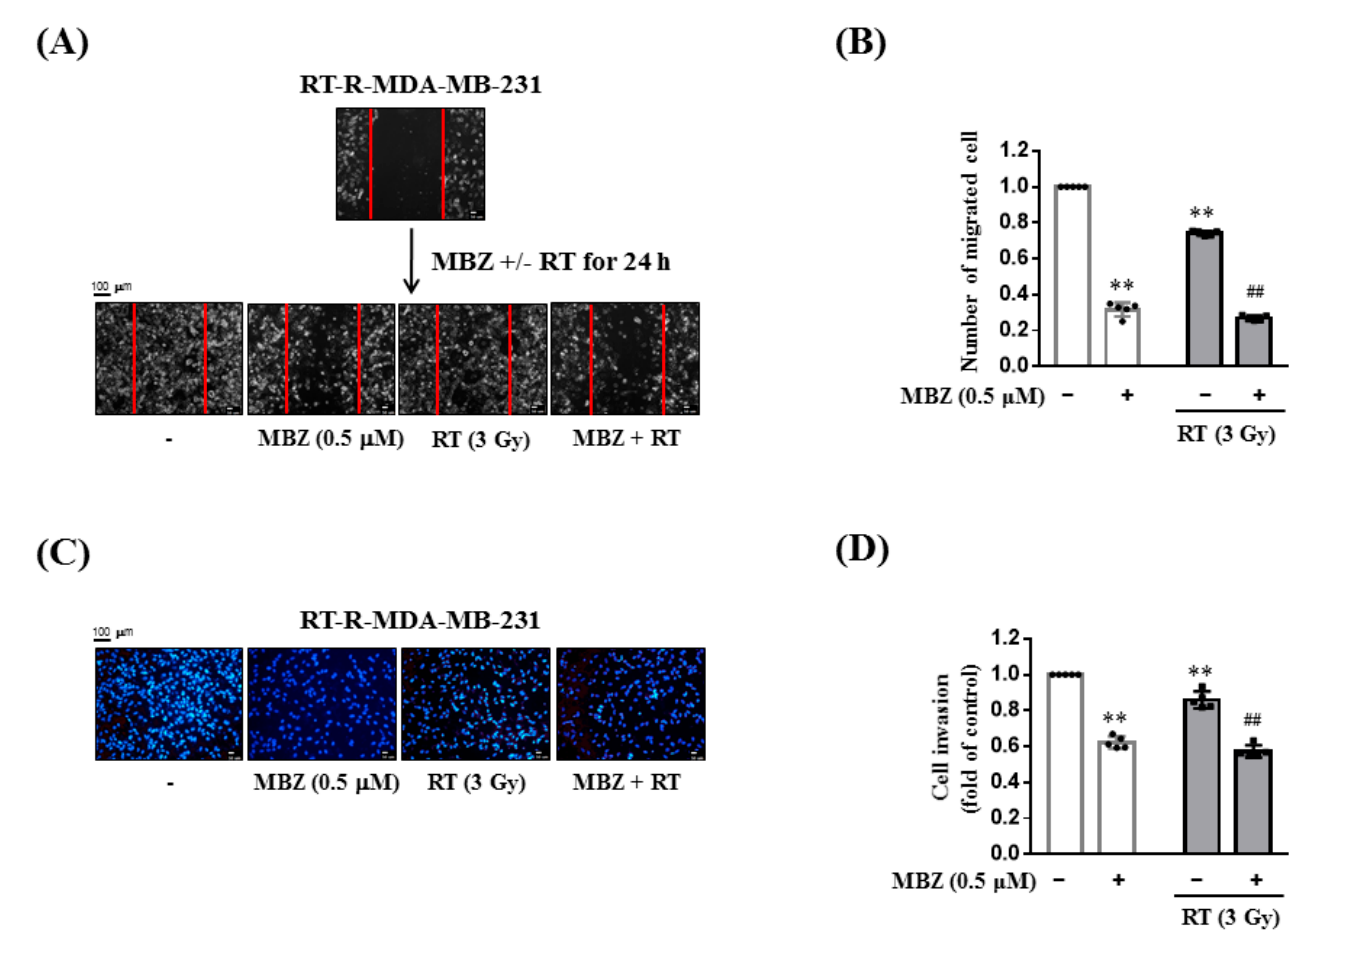
Figure 4. The combination of mebendazole (MBZ) and radiotherapy (RT) reduces scratch migration and cell invasion more effectively than RT monotherapy. ( A , B ) RT-resistant (RT-R)-MDA-MB-231 cells were cultured in 6-well plates and scratched with a sterile 200 μ L pipette tip. The cells were treated with MBZ (0.5 μ M) for 24 h and then irradiated with a 3 Gy dose of X-rays. After 24 h, cell images ( A ) were taken using an Olympus photomicroscope at 0 and 48 h after scratching and ( B ) numbers of cells that migrated into the scratch area were quantified. ( C , D ) RT-R-MDA-MB-231 cells were treated with MBZ (0.5 μ M) for 24 h and then irradiated with a 3Gy dose of X-rays. After 24 h, the cells were added to EC-Matrigel-coated insert wells and incubated for 16 h. The cells that invaded across the membrane were stained with ( C ) DAPI and ( D ) the invading cells were counted under a fluorescence microscope. The white bar graph represents the MBZ alone treatment group, and the gray bar graph represents the MBZ and radiotherapy combination group. The values are presented as the mean ± SD from five independent determinations (** p < 0.01 compared with the control; ## p < 0.01 compared with the control of RT).